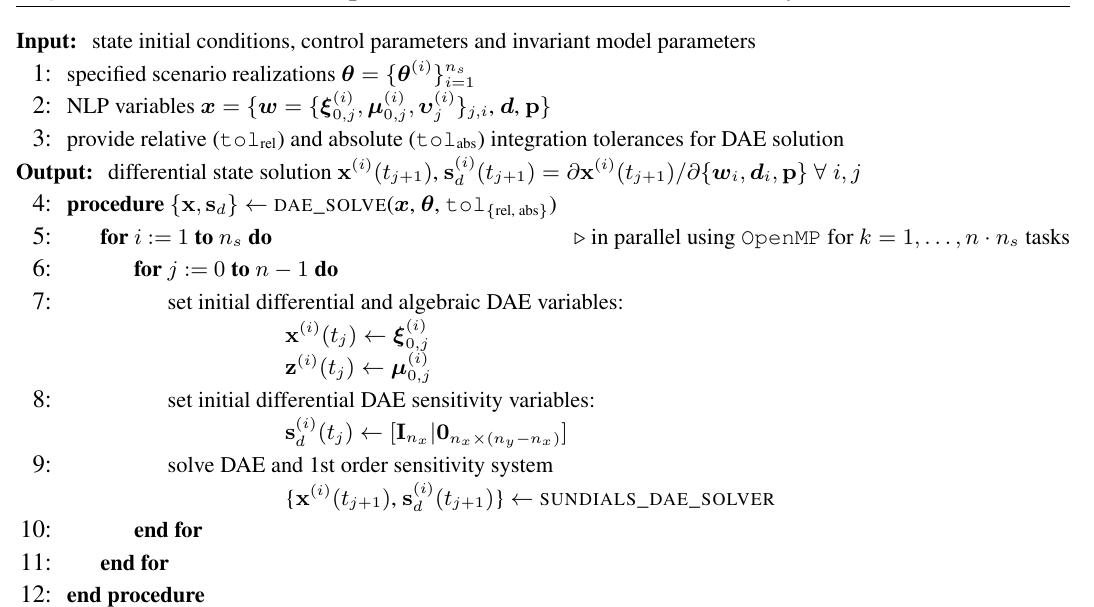
Algorithm 2 Parallel multi-period DAE and first-order sensitivity function evaluation.